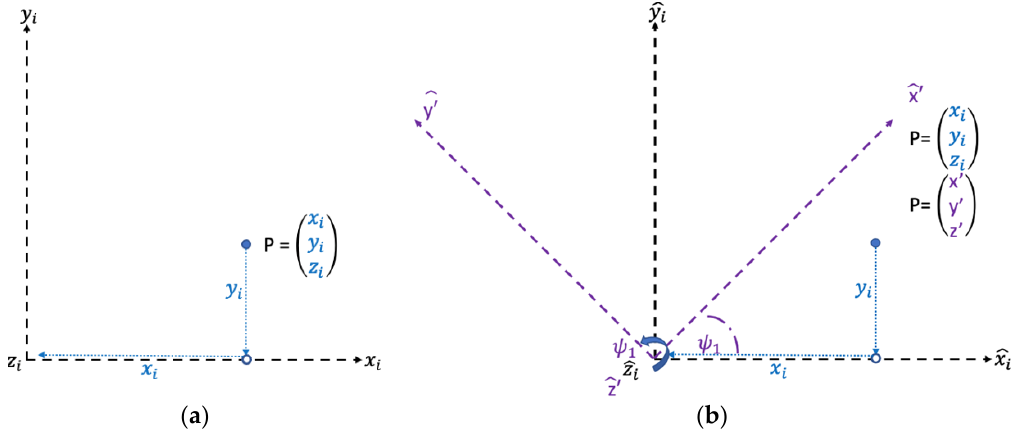
8 Figure 6. ( a – c ) Transformation from a three-dimensional view of a rotation to a two - dimensional rotation view (2DRV); ( d ) the revolutions about the z ̂ -axis, y ̂ -axis, or x ̂ -axis are known as the “3 - rotation”, “2 - rotation”, and “1 -rotation “ , respectively. This depiction is helpful because the initial and final axis is colinear, and the only changes happen to points and vectors, not on that axis. Figure 6d depicts what will be referred to as 2DRV for each rotation. The 2DRV simplifies the dimensionality and makes the development of the equations simpler to see and understand. Developing each rota- tion creates a matrix and must be performed one revolution at a time. Each rotation is identified by the axis it is rotated around. After each matrix is completed, they can be combined to create an overarching direction cosine matrix. The following direction cosine matrix creation uses the proposed method. Using the 3, 2, and 1 order of rotations, or the 3-, 2-, 1-direction cosine matrix, will take the inertial frame to a body frame. In this description, the order of the rotation also follows the num- ber order. However, it is essential to note that any combination of rotations or translation types can be performed similarly. While the order does not matter, the 3-rotation is the